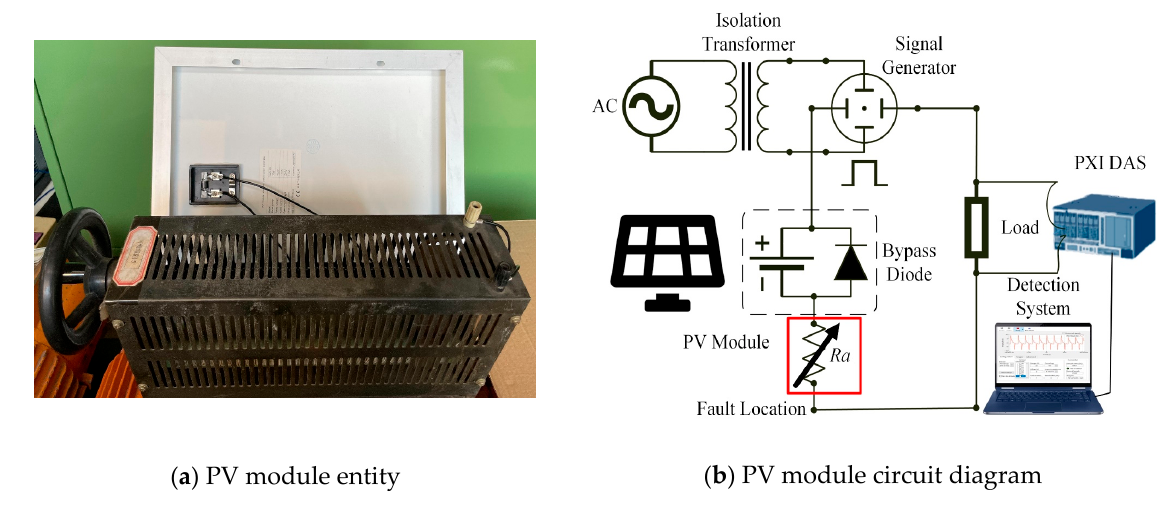
Figure 8. Contact defectiveness of the built-in PV module.